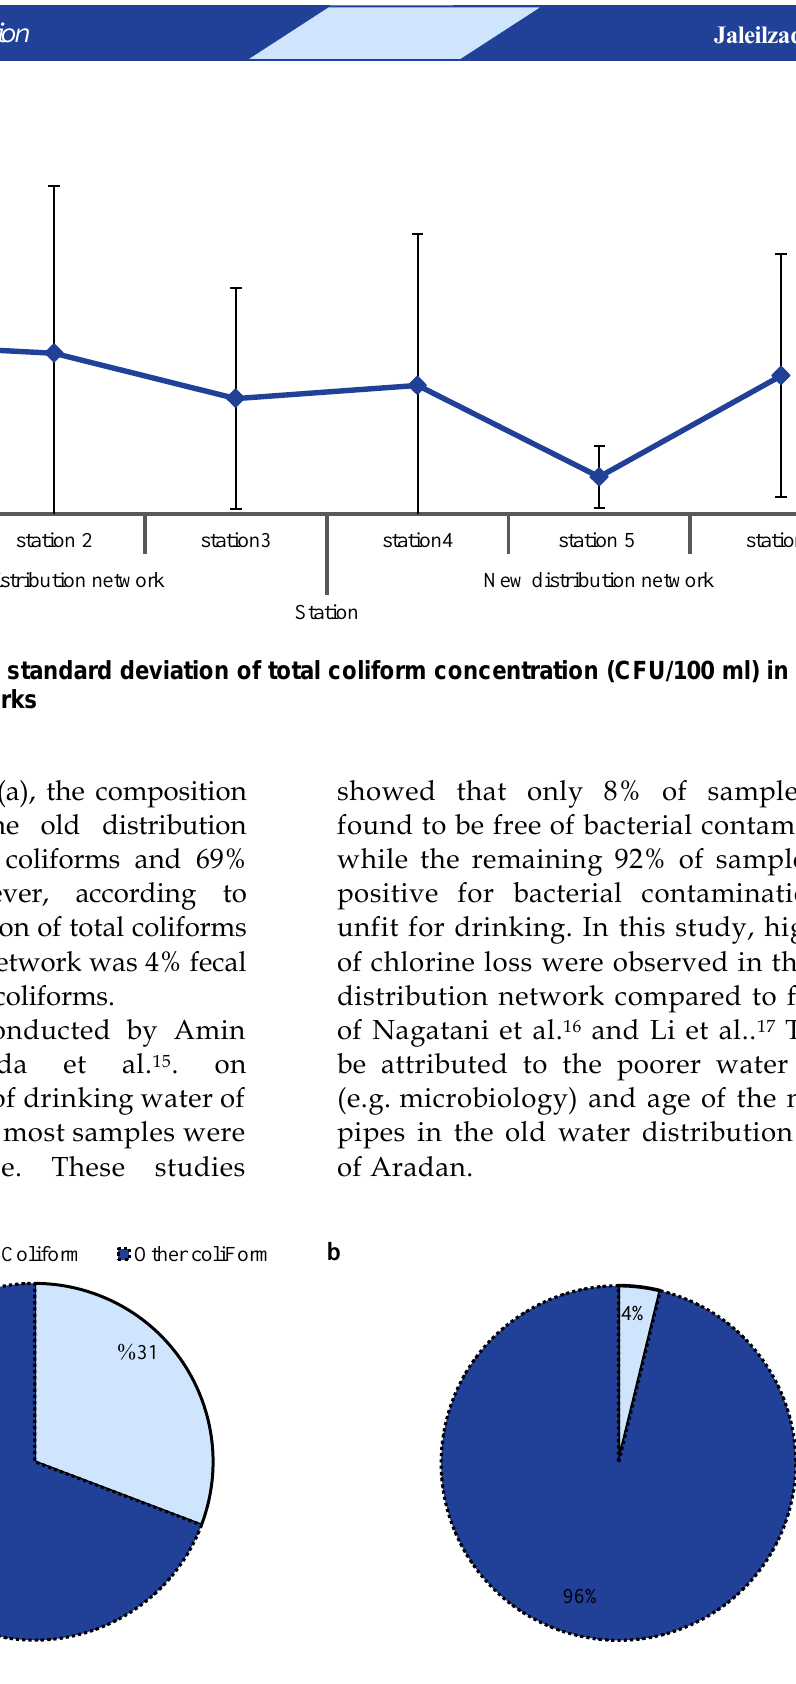
Figure 2. Composition of coliform in the (a) old and (b) new distribution